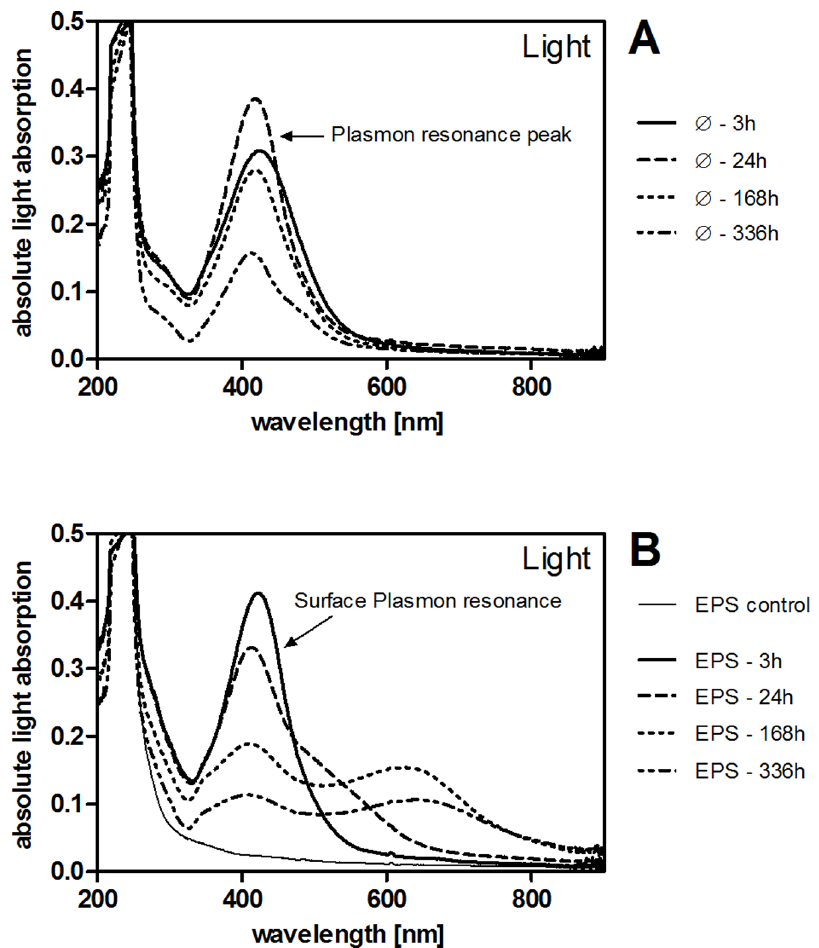
Figure 5. A–B: Spectra of absolute light absorption of 5 mg/L Ag NP as determined by UV-VIS spectroscopy. Samples were incubated in light (100 m E/m 2 s) at pH 6 without ( A ) or with EPS ( B , 10 mg DOC/L; 3–168 h spectra obtained with EPS extract 1; 336 h spectrum obtained with EPS extract 4). EPS control ( B ) contained 10 mg DOC/L EPS in 2 mM NaHCO 3 . Different EPS extracts did not differ in absorption of light . 300 nm.